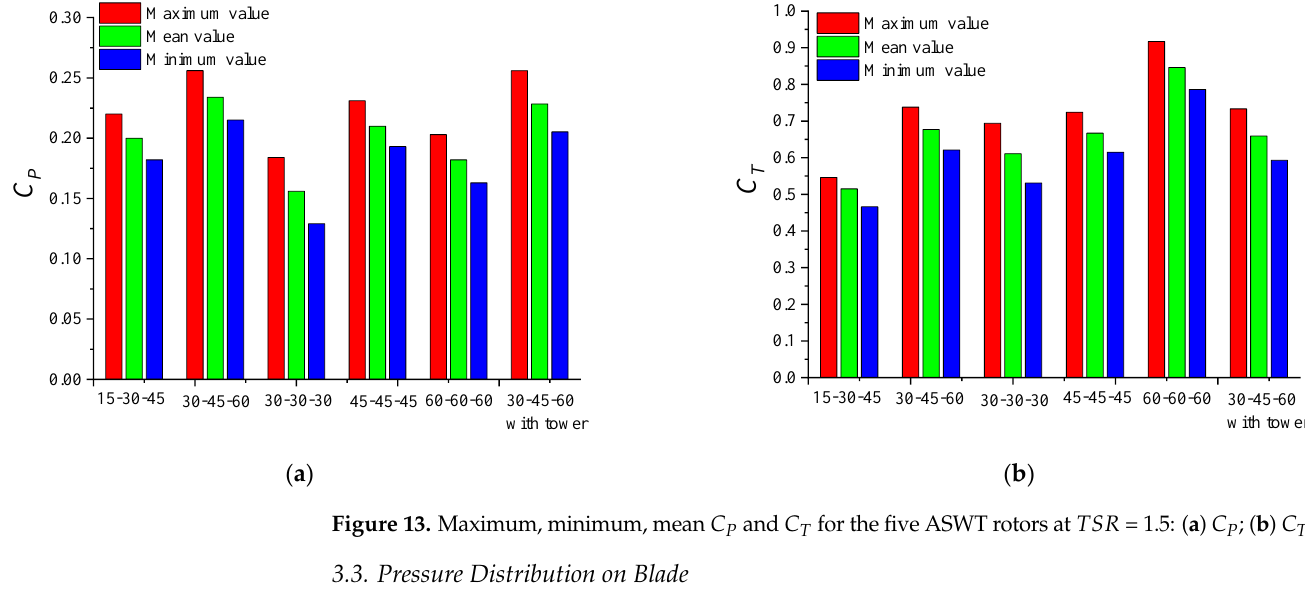
C and C for the five ASWT rotors at T S R =1.5: ( a ) T P